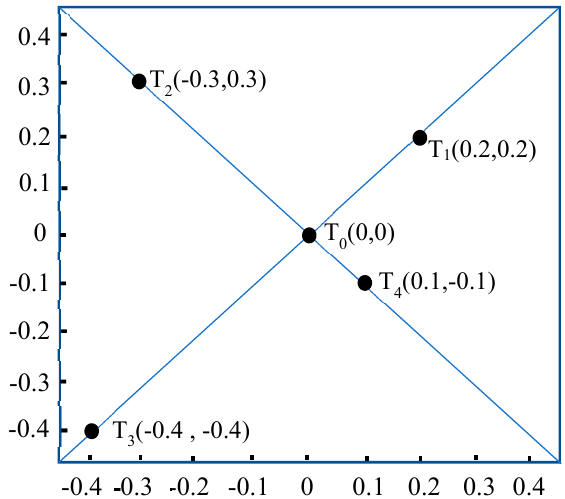
Figure 9. Optical attenuation correction model verification panel. Table 7. Predicted light intensity and measured light intensity.